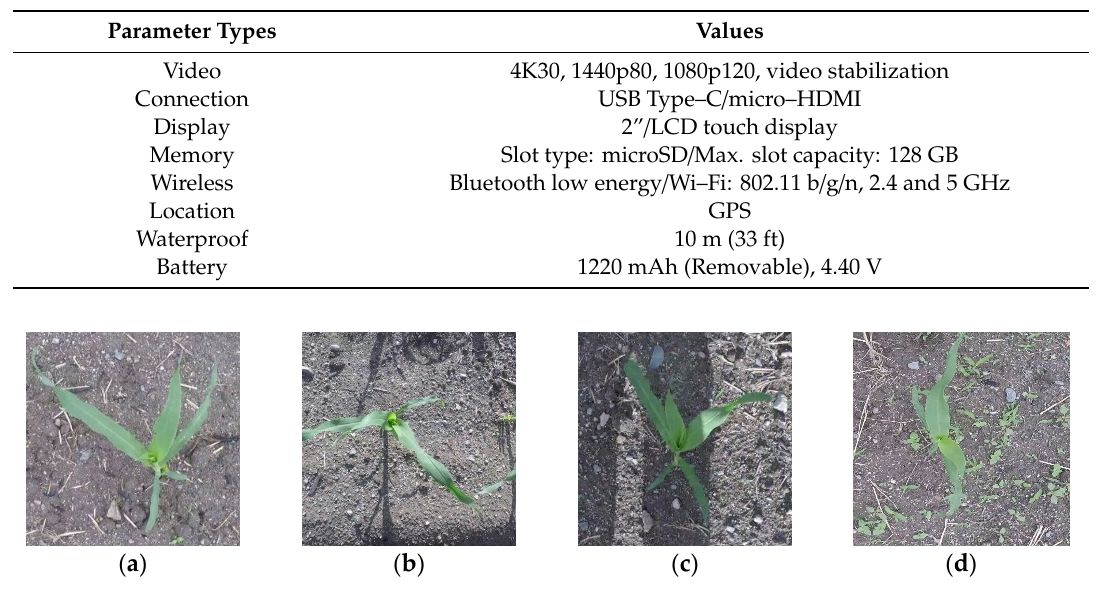
Figure 6. Image samples under different environmental cases: ( a ) cloudy days; ( b ) sunny days; ( c ) shadow background; ( d ) weed background.